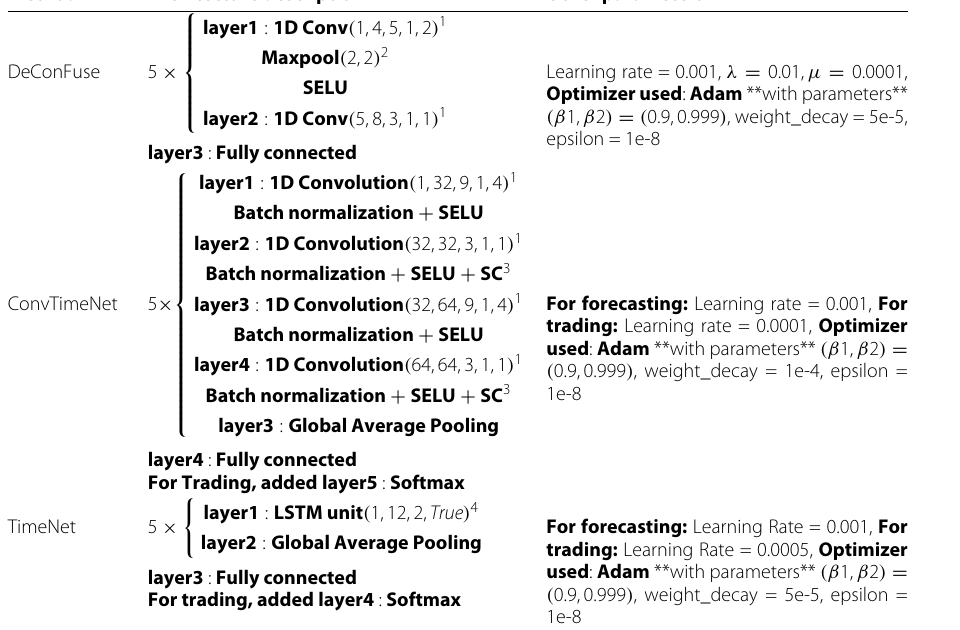
Table 2 Description of compared models Method Architecture description Other